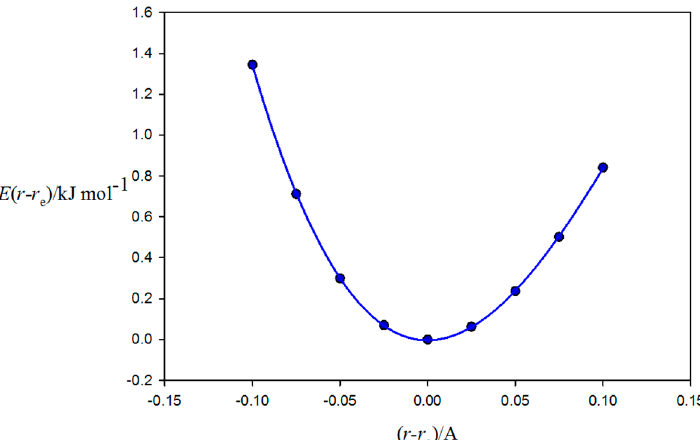
Figure 11. Variation of the energy E ( r − r e ) of OC ··· BeF 2 as a function of the displacement ( r − r e ) from the global minimum at r e along the C 2 axis of this Y-shaped complex. (F–Be–F) forms the arms of the Y and CO forms the stem. See Figure 3 for a molecular diagram. The geometry was re-optimized at each of the indicated points and the line through the points is the third-order polynomial curve from the regression fit to the points. The second derivative evaluated at r e gives the intermolecular stretching force constant, k σ . The corresponding curves and the fitted polynomials for all B ··· BeR 2 and B ··· MgR 2 complexes (B = CO, H 2 S, PH 3 , HCN, H 2 O or NH 3 ; R = F, H or CH 3 ) investigated here are available in the Supplementary Material.